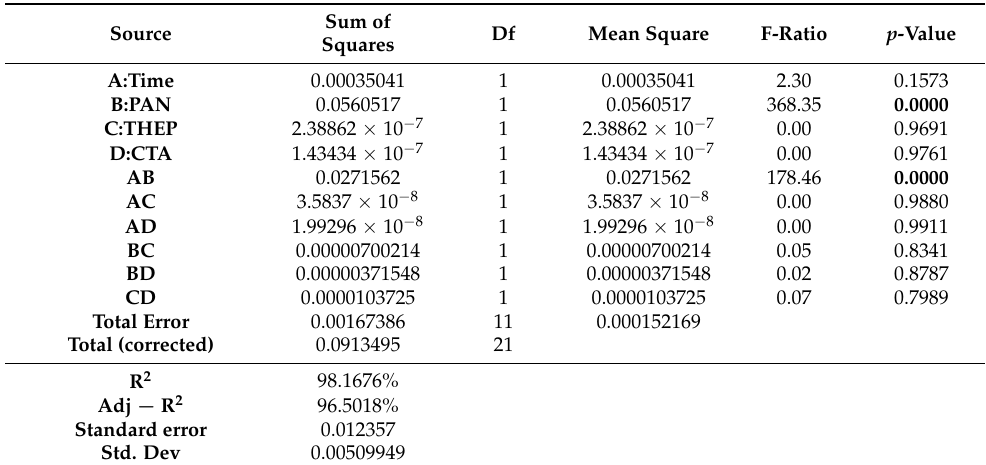
Table 6. Analysis of variance (ANOVA) results for the system PAN-Cd(II).